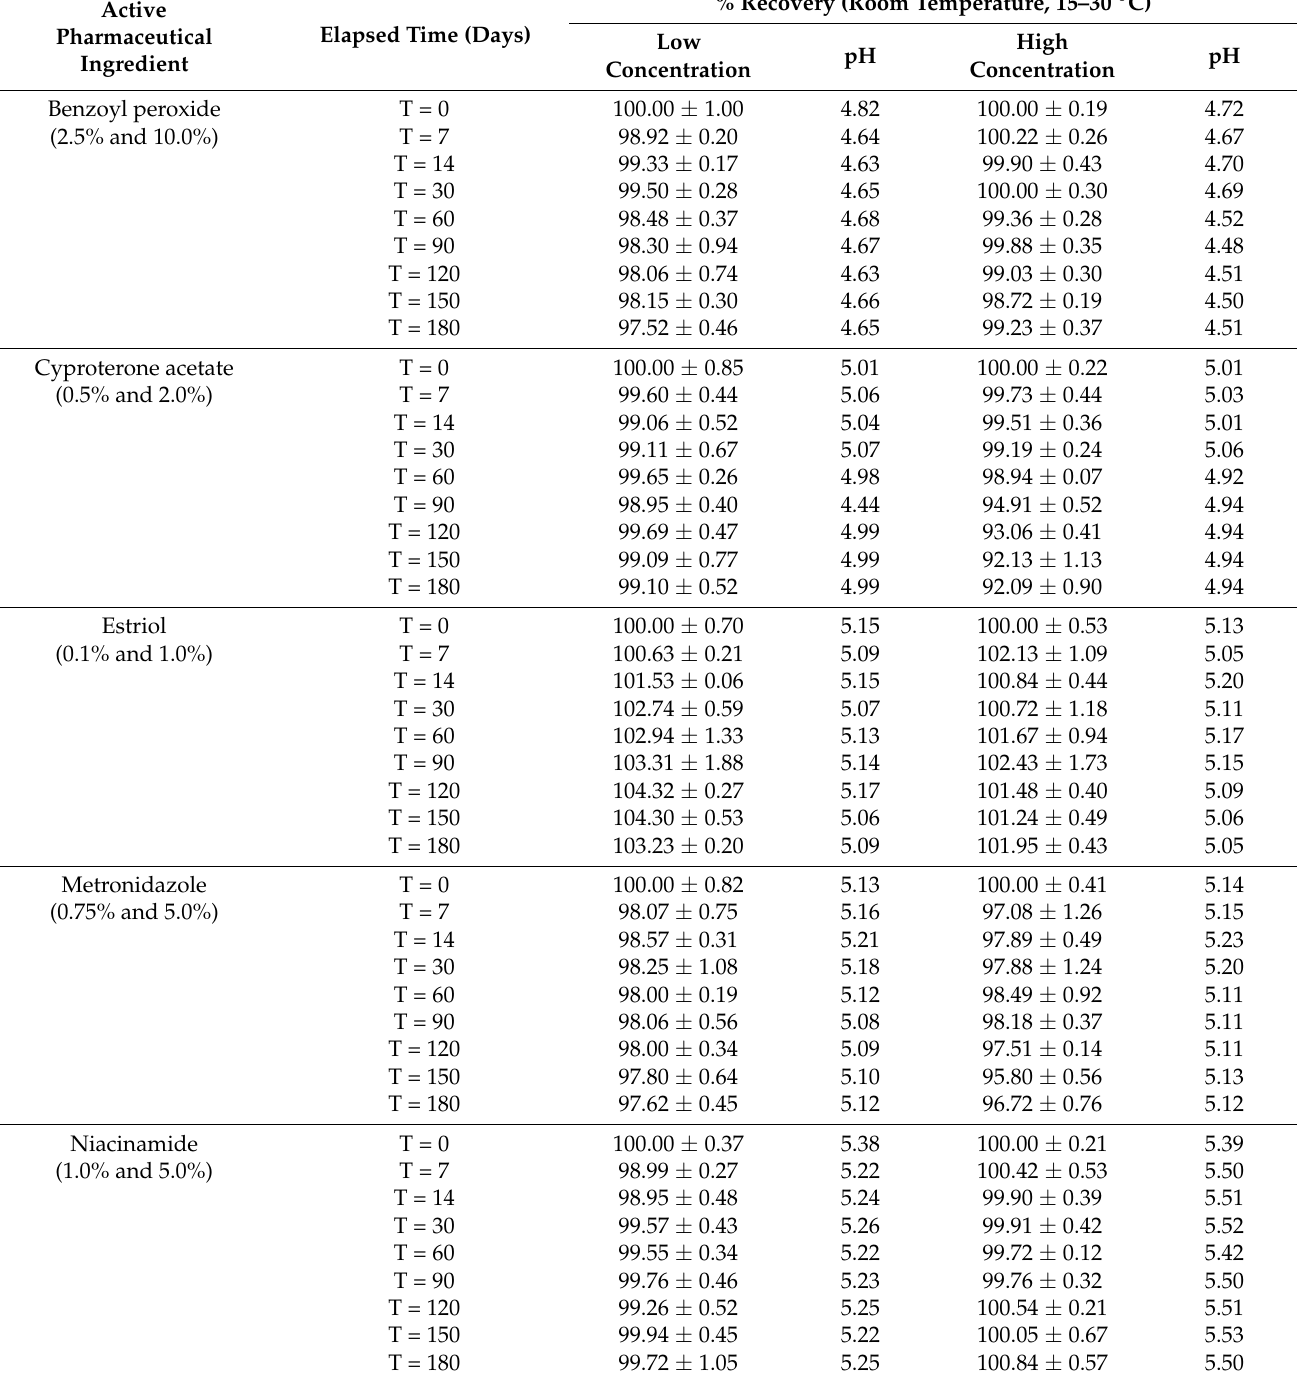
Table 5. APIs’ chemical stability in Cleoderm™, measured by